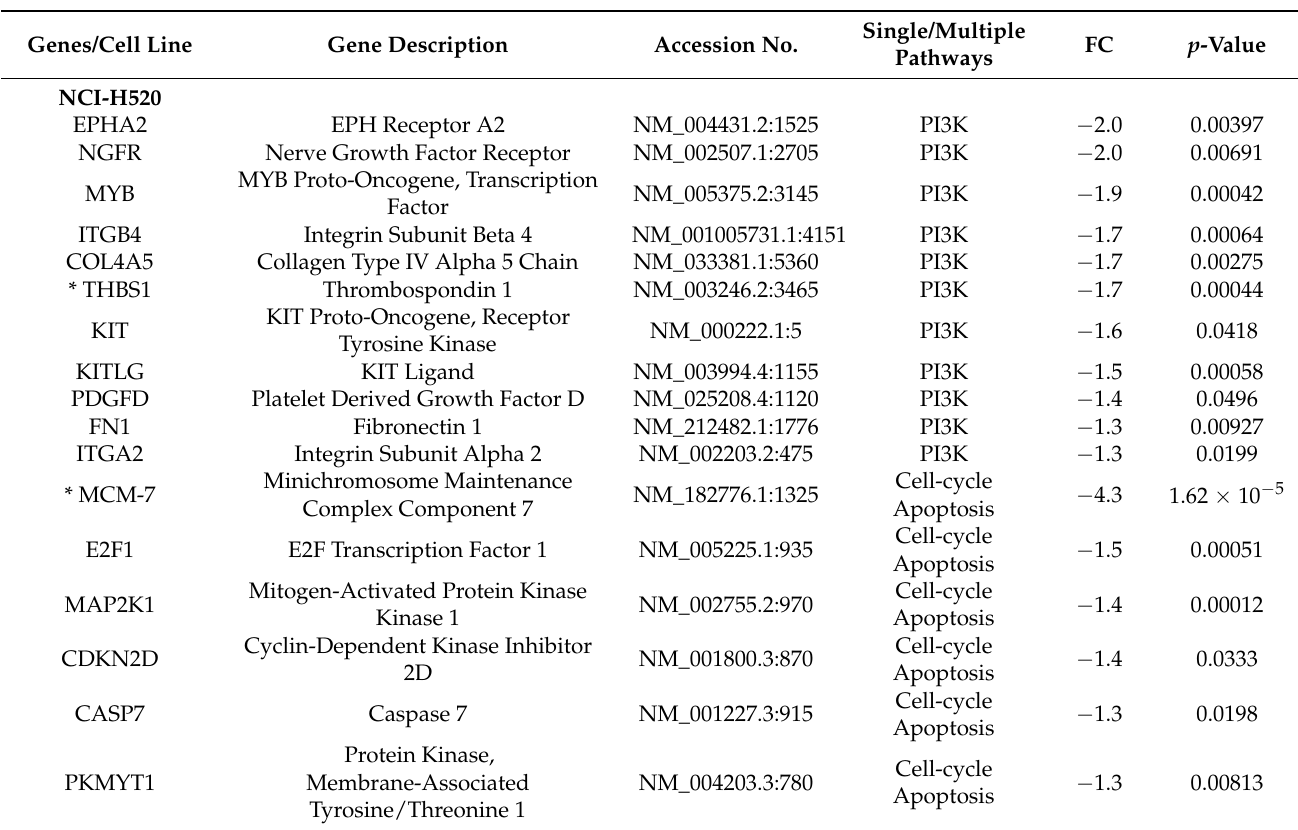
Table 3. Downregulated DEGs in NCI-H520 and NCI-H23 cells in response to MS13